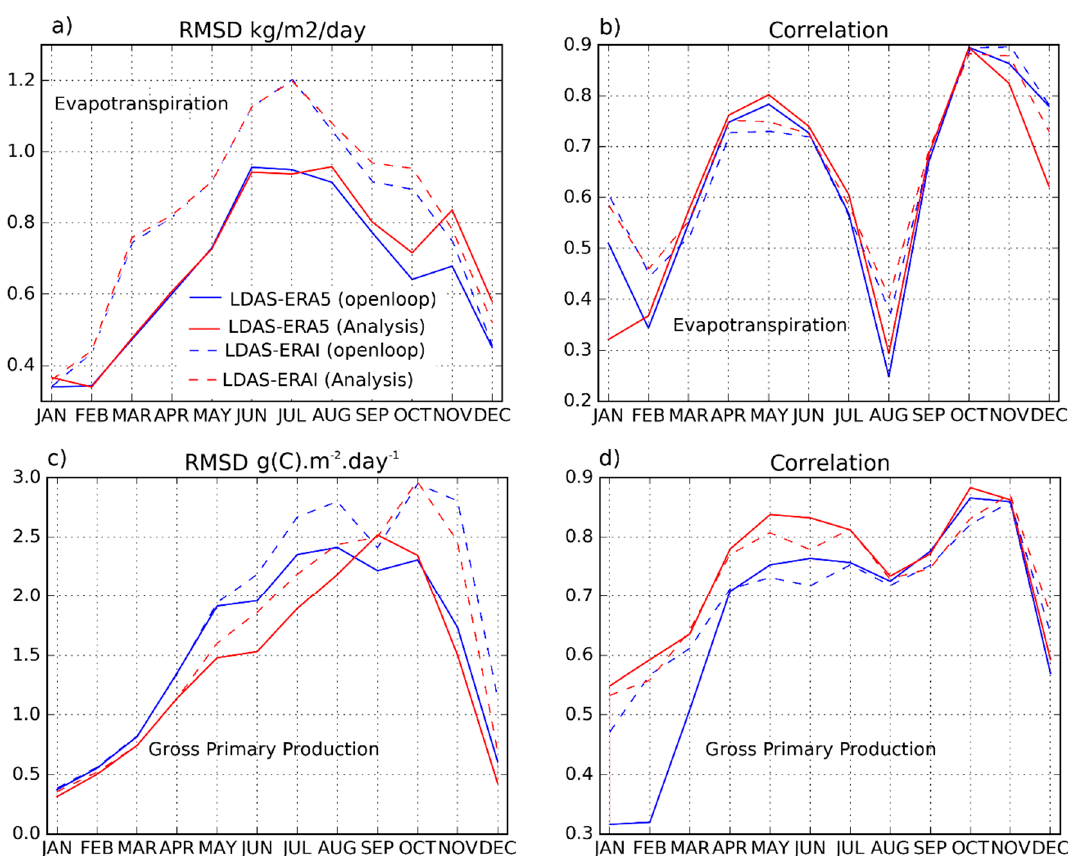
Figure 14. Seasonal evapotranspiration ( a , b ) and gross primary production (GPP) ( c , d ) scores when compared to the observations over January 2001 to June 2018.